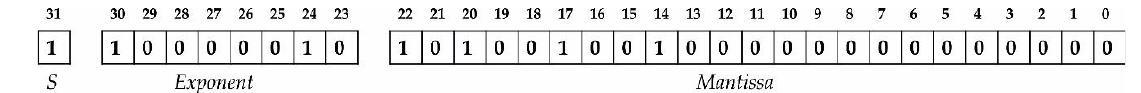
Figure 1. Representation of the decimal number − 13.140625 according to the IEEE 754 single precision standard. The numbers from 0 to 31 highlight the bit position in the digital string.